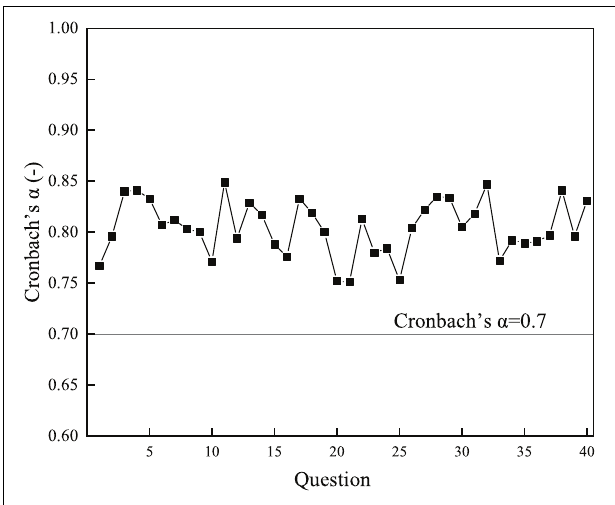
FIGURE 3 | Analysis results of the reliability of the questionnaire.